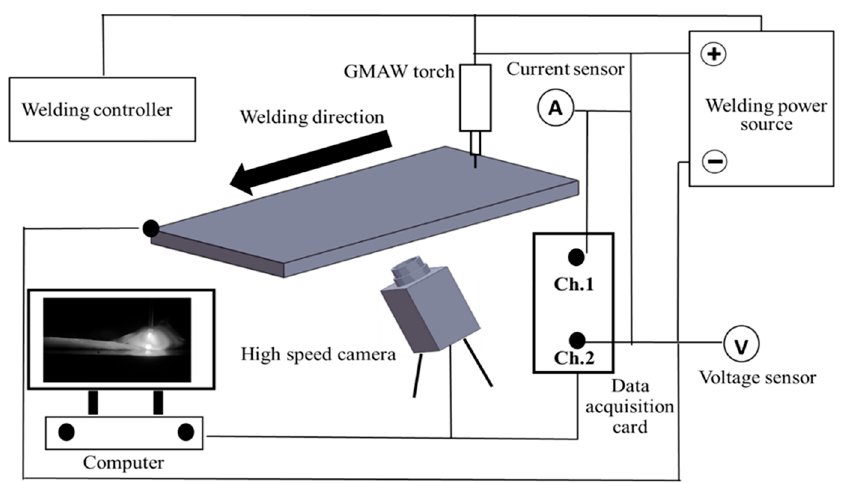
Figure 2. Schematic of the experimental setup for synchronization of arc imaging with welding signal. GMAW—gas arc metal welding.